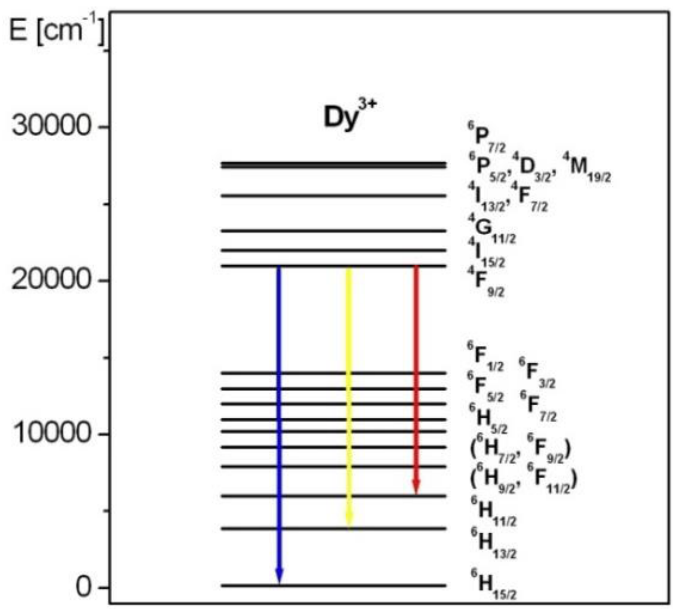
Figure 5. Energy level diagram for Dy 3+ ions. Luminescent transitions are also indicated.